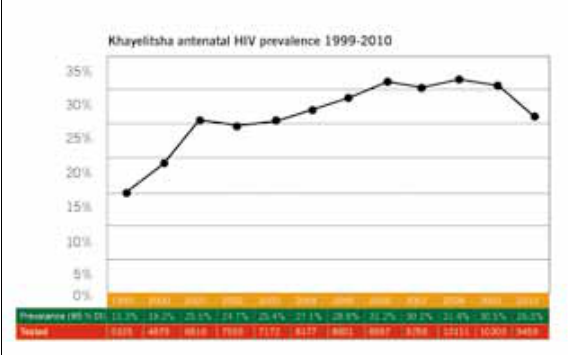
Fig. 1. Rate of mother-to-child HIV transmission, 2002 -